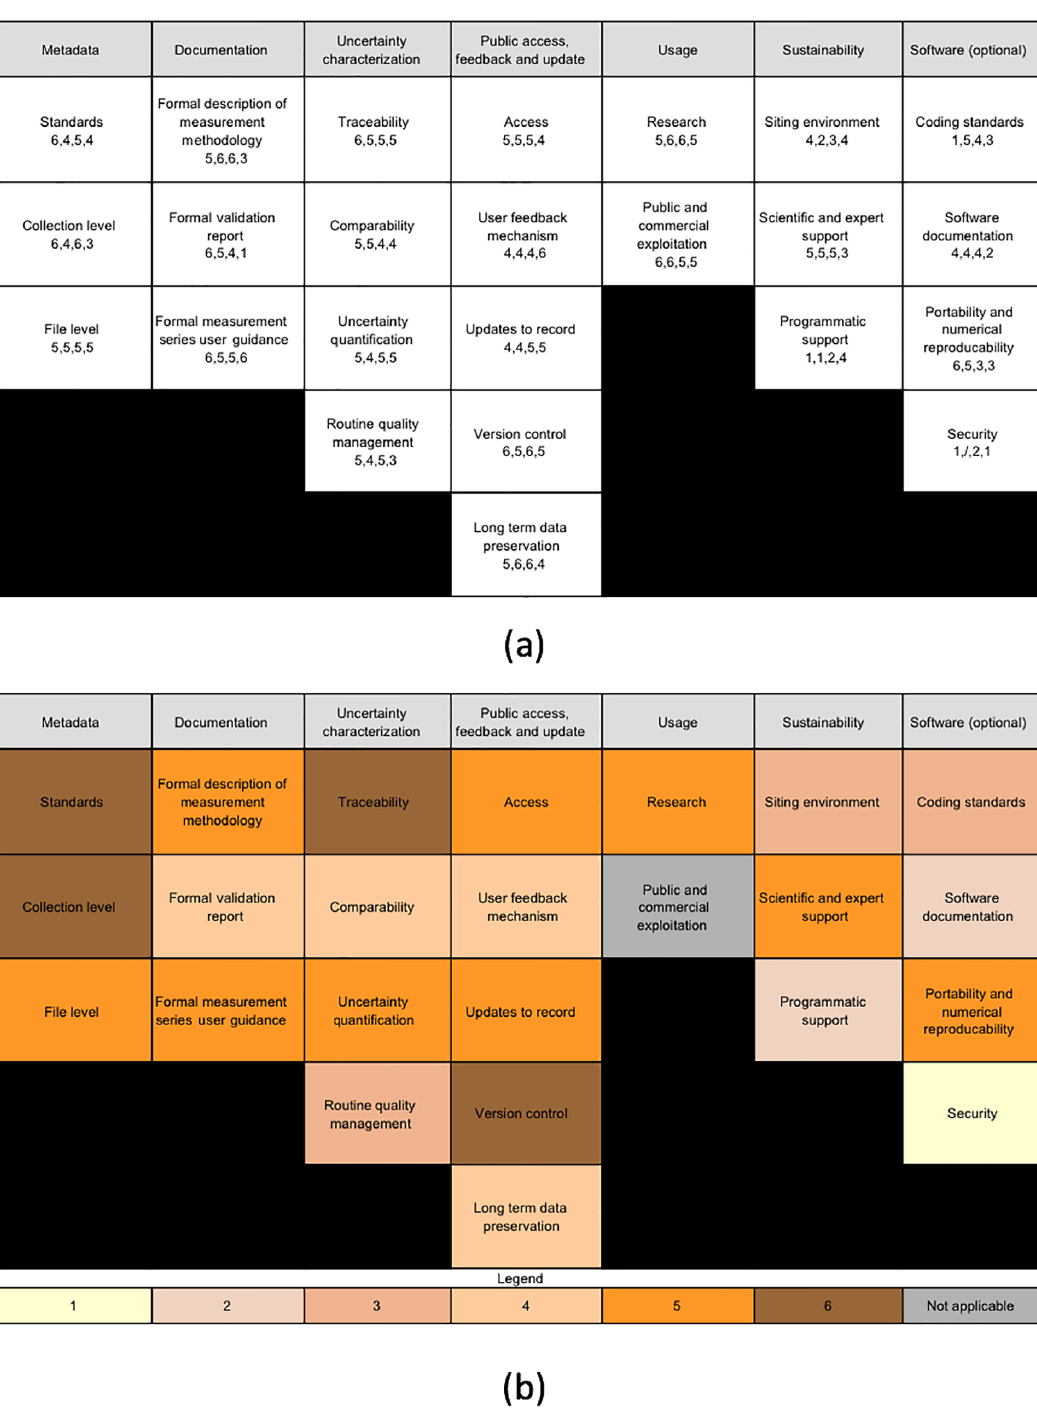
Figure 5. Range of original assessments (a) and final collated assessment (b) for TCCON network. In (a) assessments that differ by more than one are highlighted in bold. The four assessors are always given in the same